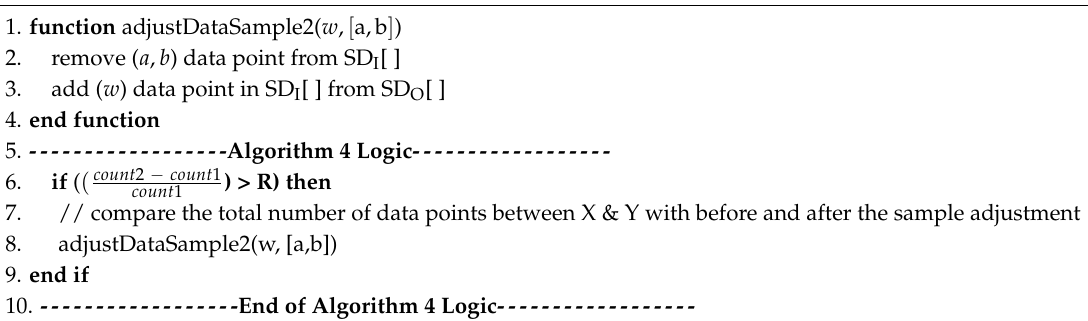
Algorithm 4. Adjustment of data points sample based on total number of data